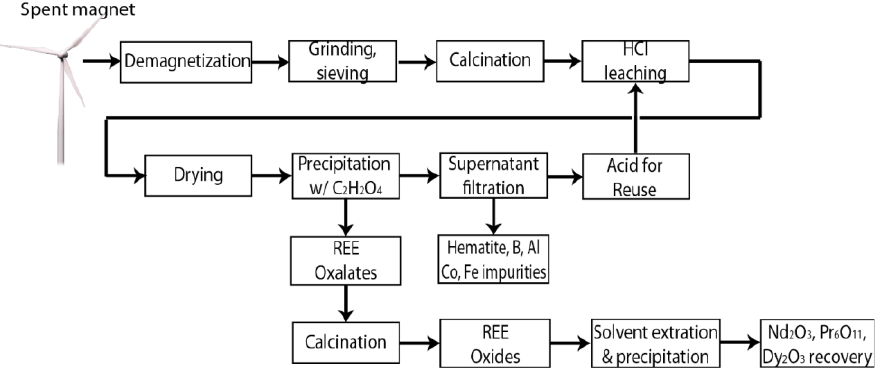
Figure 8. Recycling of NdFeB magnet from wind turbine by acid leaching, calcination and precipitation with oxalic acid flow chart .